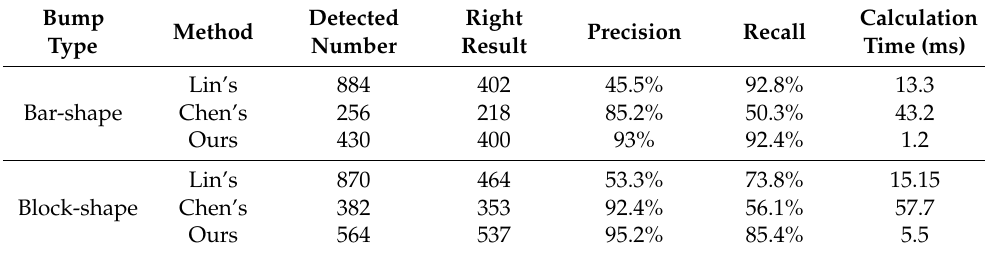
Figure 15. Examples of different detection methods on bar-shape bumps and block-shape bumps. Table 6. The comparison of detection results of different